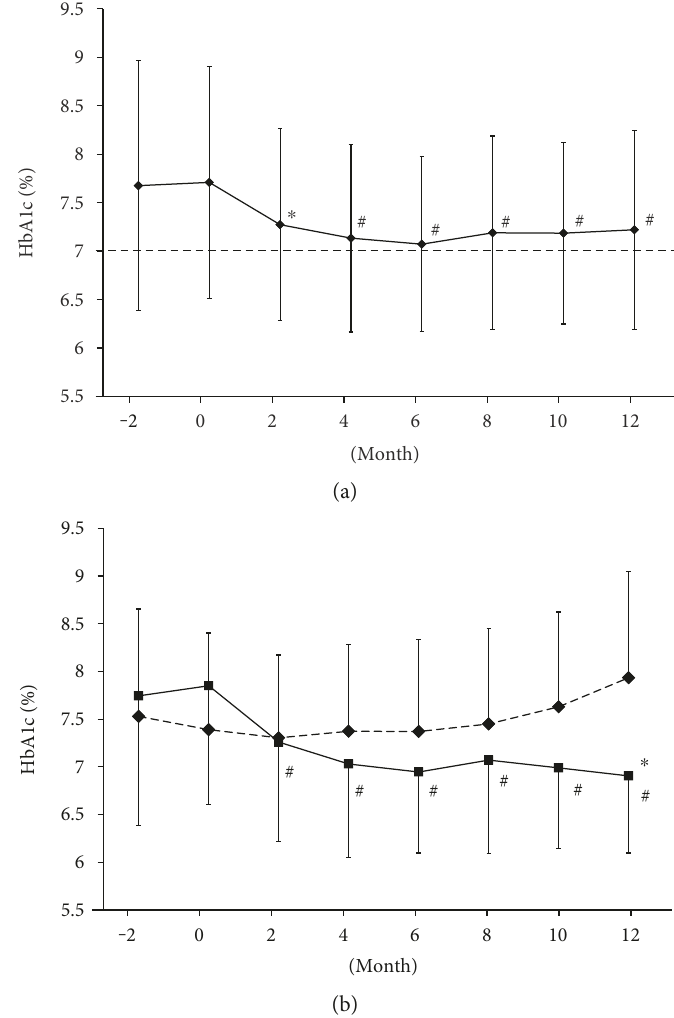
Figure 1: (a) Alteration of HbA1c levels after starting DPP-4 inhibitor in all participants (overall trend: p < 0 0001 ). ∗ p < 0 0005 versus baseline; # p < 0 0001 versus baseline. Data are shown as mean ± SD. (b) Alteration of HbA1c levels after starting DPP-4 inhibitor in the e ff ective group (solid line) (overall trend: p < 0 0001 ) and the ine ff ective group (dashed line) (overall trend: p < 0 01 ). ∗ p < 0 0001 versus the ine ff ective group at the same time point; # p < 0 0001 versus baseline in the e ff ective group. Data are shown as mean ±